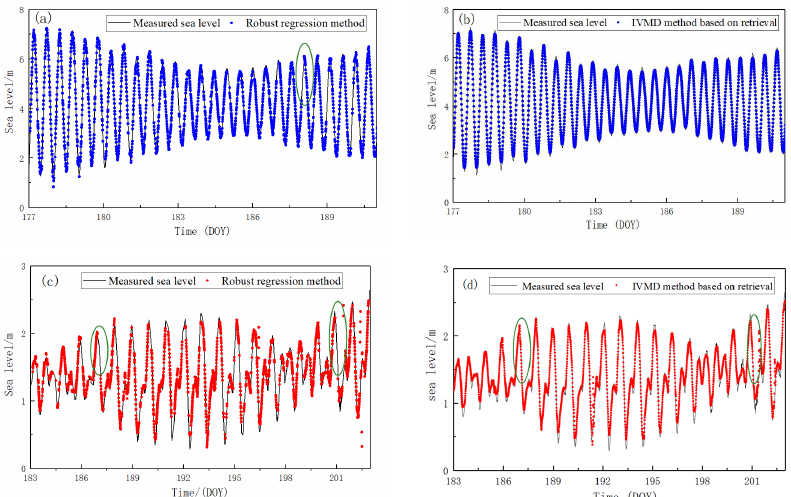
Figure 7. Results of robust regression and IVMD algorithm for the stations: ( a ) the results of robust regression algorithm for the BRST during DOY 177–191, 2021; ( b ) results of IVMD algorithm for the BRST during DOY 177–191; ( c ) results of robust regression algorithm for the HKQT during DOY 177–191; ( d ) results of IVMD algorithm for the HKQT during DOY 177–191.